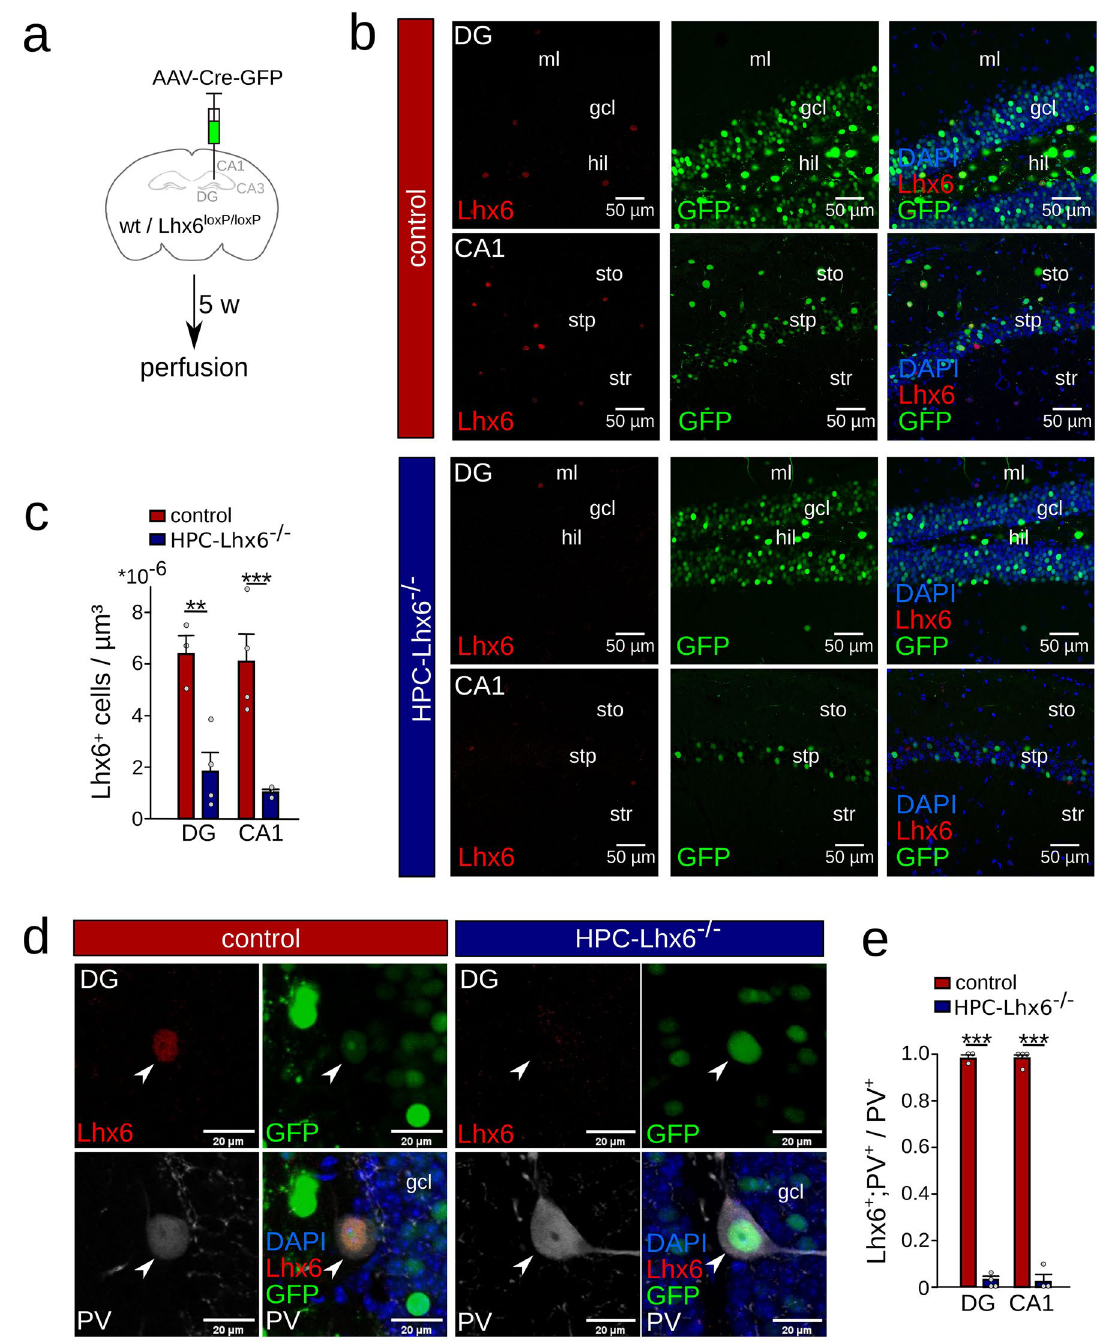
Figure 1. Removal of Lhx6 from adult PVIs. ( a ) Schematic of the experimental procedure used to remove Lhx6 from PVIs. Stereotaxic injections of adeno-associated viruses encoding Cre-recombinase were targeted to the hippocampus of mice carrying two alleles of the Lhx6 gene flanked by loxP-sites (HPC-Lhx6 −/− mice) or wildtype control mice. ( b ) Confocal image stacks of the dentate gyrus (DG) and CA1 showing the expression of Lhx6 (red), Cre-GFP (green), and DAPI (blue) in control (top) and HPC-Lhx6 −/− mice (bottom). Gcl: granule cell layer; hil: hilus; ml: molecular layer; stp: stratum pyramidale; sto: stratum oriens; str: stratum radiatum. ( c ) Quantification of the number of Lhx6-positive neurons revealed a significant reduction in HPC-Lhx6 −/− compared to control mice. ( d ) Examples of the colocalisation of Lhx6 (red), Cre-GFP (green) and parvalbumin (PV, grey) in the DG. Lhx6 immunoreactivity is absent in the majority of PVIs in HPC-Lhx6 −/− mice. ( e ) Quantification of the colocalisation of Lhx6 and PV in Cre-GFP-positive neurons. Data are mean ± sem. 3–4 mice were used per group. Data points show mouse averages. **p < 0.01, ***p < 0.001. Schematic in ( a ) was created with Inkscape 0.92 (www. inksc ape.